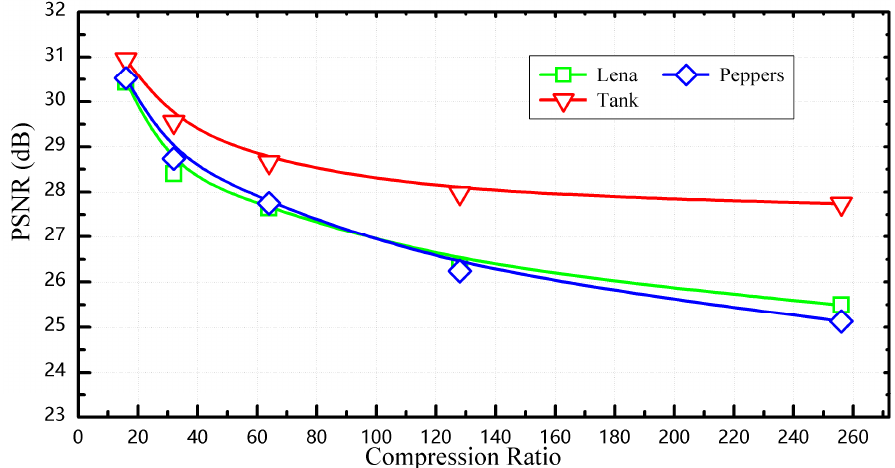
Figure 6. Visual quality comparisons between the compressed images for ( a ) Lena, ( b ) Peppers, and ( c ) Tank. The images in each row from the left to the right are the compressed images as the sizes of pixel-block are 4 × 4 (the corresponding compression ratio is 16), 4 × 8 (the corresponding compression ratio is 32), 8 × 8 (the corresponding compression ratio is 64), 8 × 16 (the corresponding compression ratio is 128), and 16 × 16 (the corresponding compression ratio is 256), respectively.